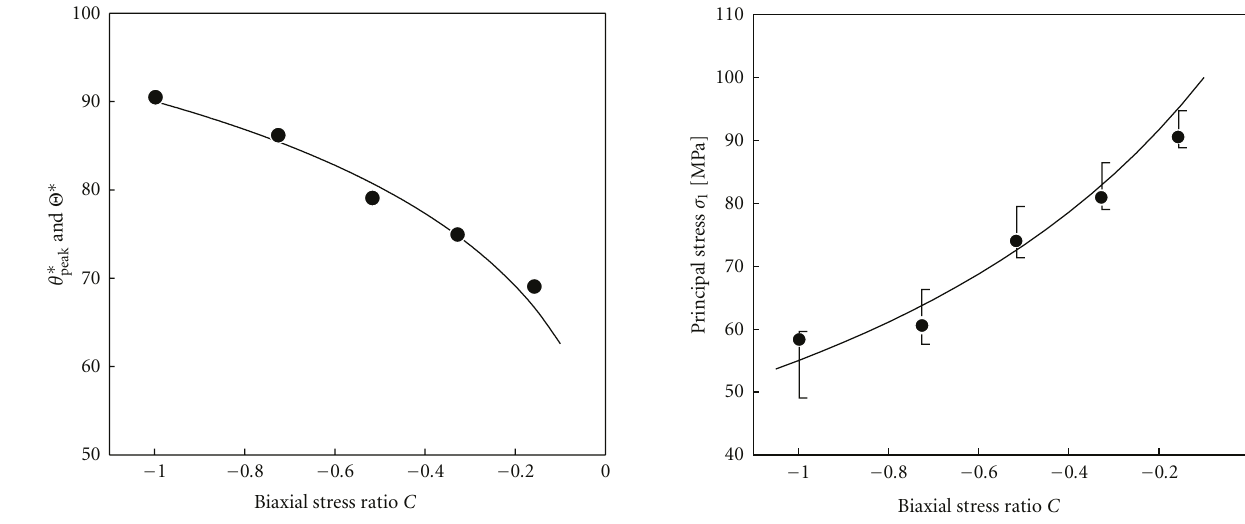
Figure 12: Relationship between σ 1 and C ( δ = 3%).